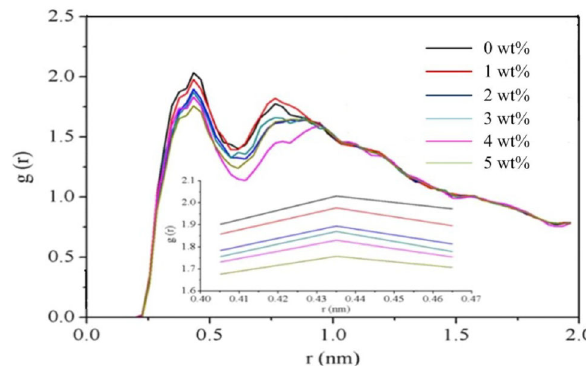
Fig. 8 Radial distribution functions (RDFs) between CH 4 and oxygen atoms in kaolinite in dry and moist kaolinite at 293.15 K and 5